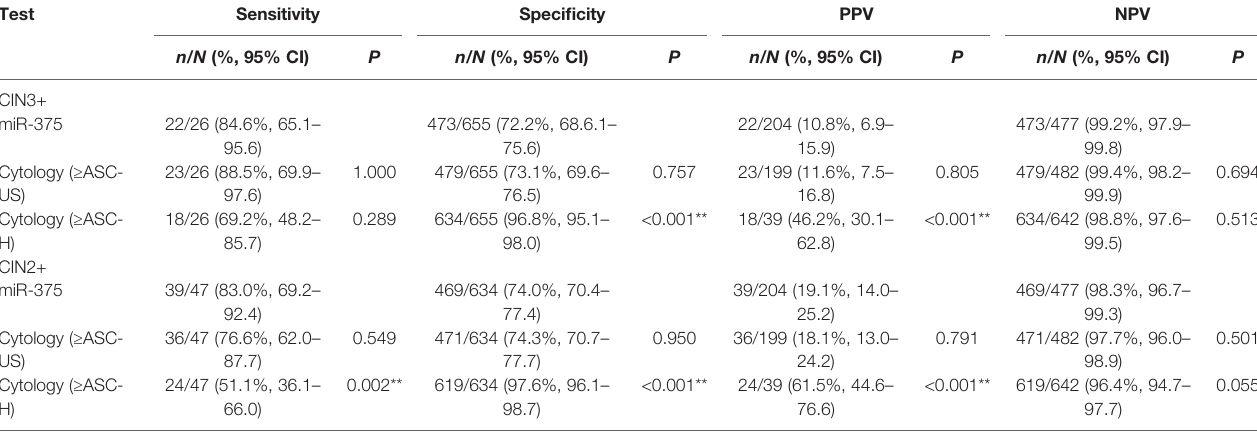
TABLE 2 | Comparison of performance ef fi ciency among miR-375 and cytology tests for detecting CIN3+ and CIN2+ in HPV non-16/18+